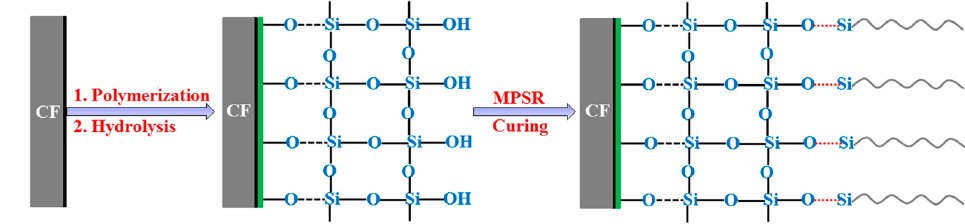
Figure 6. The possible mechanism of binding the SiO 2 layer onto the PDA pre-modified CF surface and the interfacial reaction of CF/PDA/SiO 2 composites.